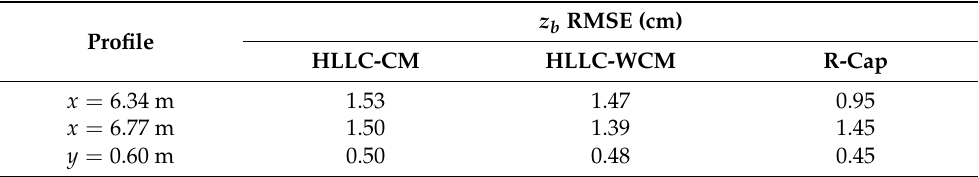
Table 5. Bed-level z b RMSE for Profiles x = 6.34 m, x = 6.77 m, and y = 0.60 m with the R-Cap, HLLC-CM and